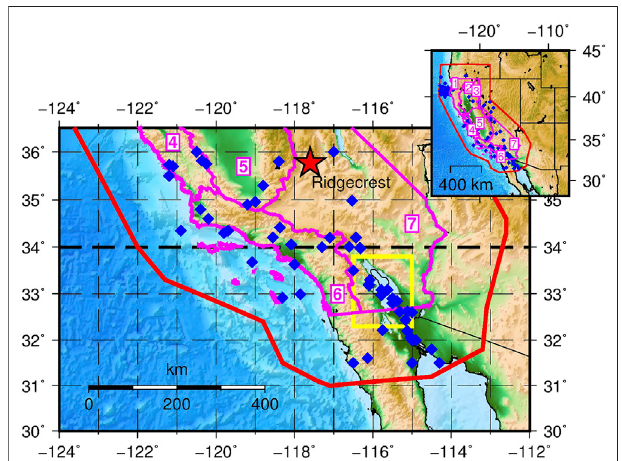
FIGURE 1 | Epicenters of the mainshocks with Mw ≥ 5.7 occurred in Southern California and the surrounding area between 1900 and 2020 (blue diamonds, the red star represents the epicenter of the Ridgecrest earthquake of July 6, 2019, Mw 7.1). In red the border of the area covered by the earthquake catalog; in magenta the borders of the climatic divisions of California enumerated from 1 to 7; in yellow the Salton Trough